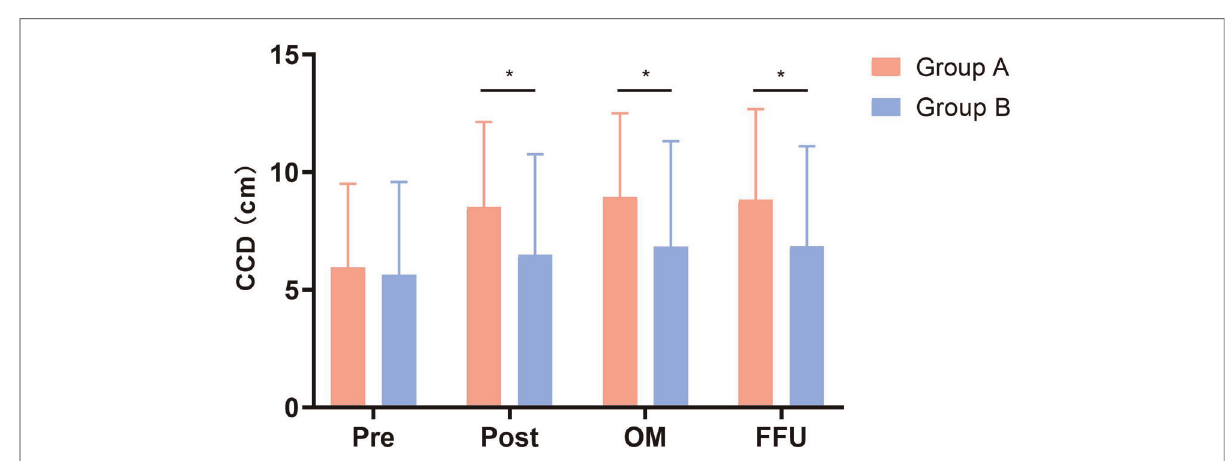
FIGURE 6 Comparison of cervical curve depth (CCD) between two groups. Pre, pre-operative; Post, postoperative; OM, one month after surgery; FFU, fi nal follow-up. *Signi fi cance between the two groups, P